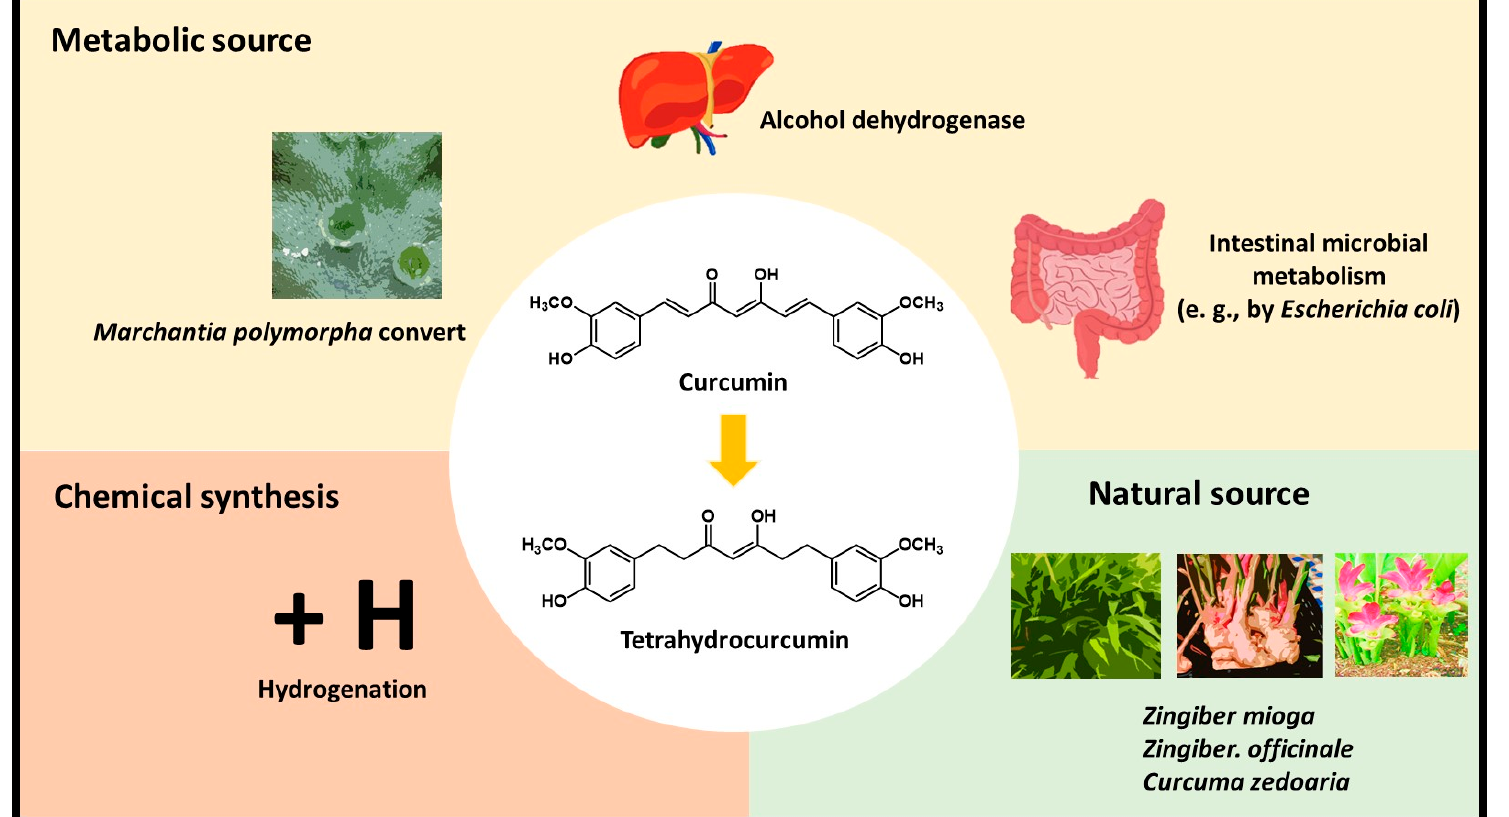
Figure 1. The sources of tetrahydrocurcumin.